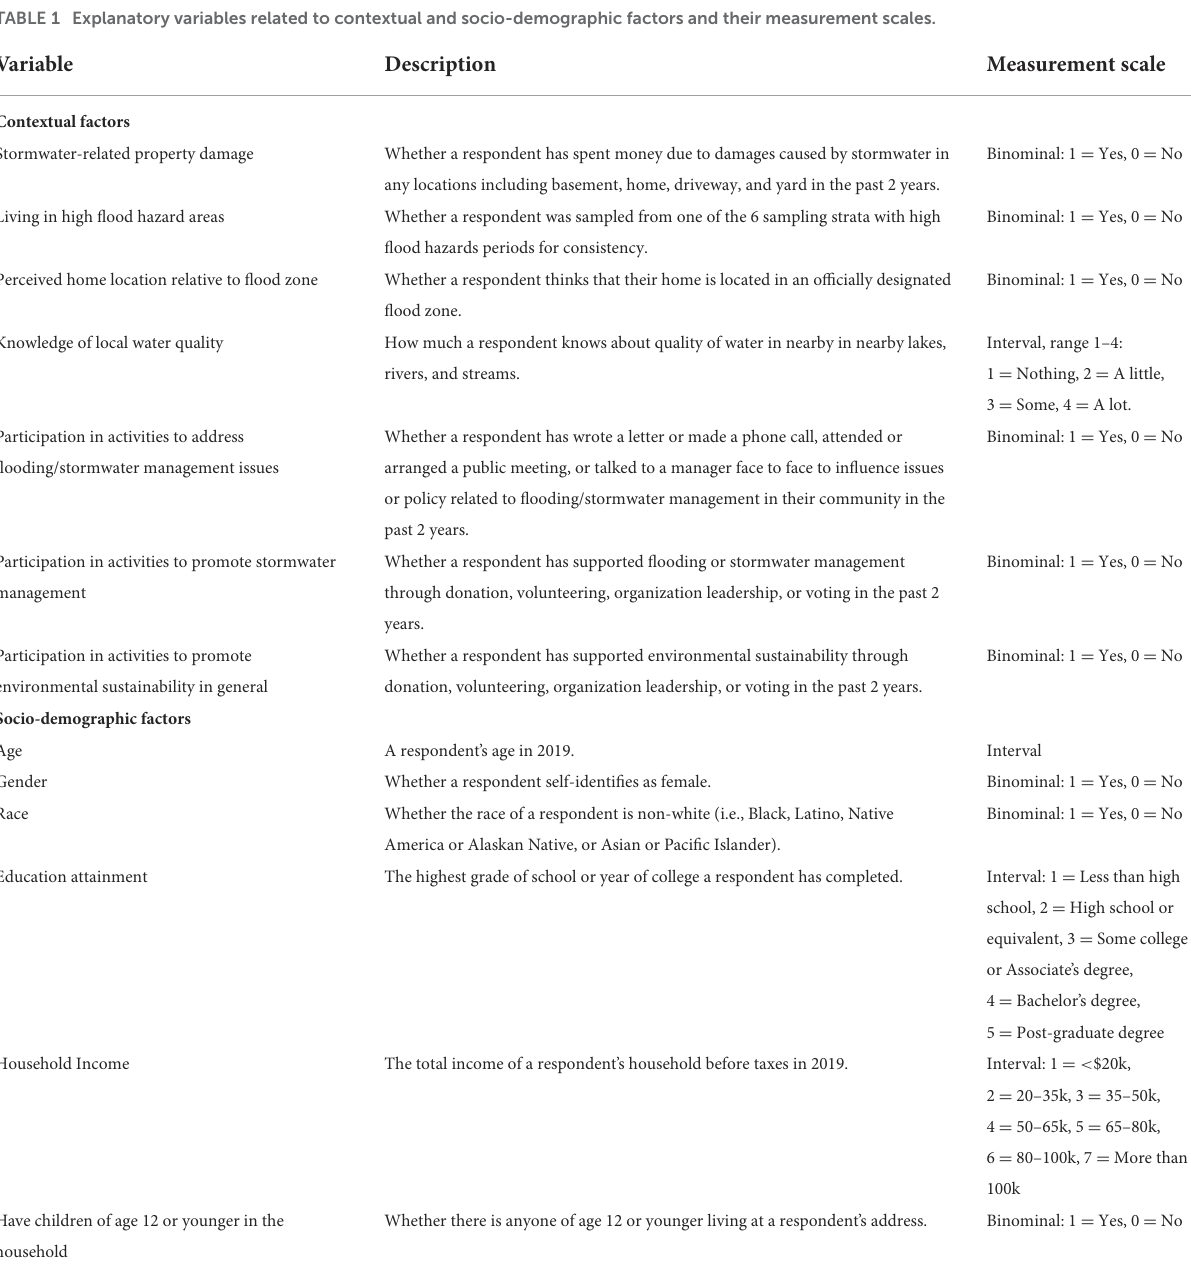
TABLE 1 Explanatory variables related to contextual and socio-demographic factors and their measurement scales. Variable